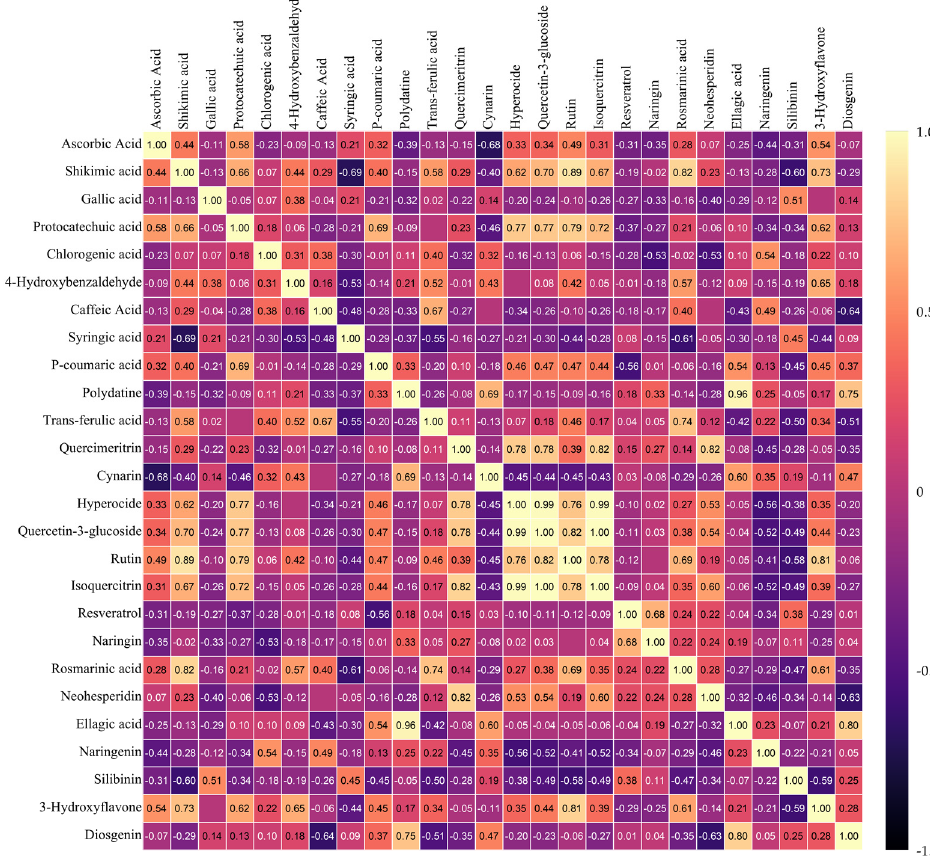
Figure 10. Correlation analysis of phenolics and flavonoids corresponding to the treatments.